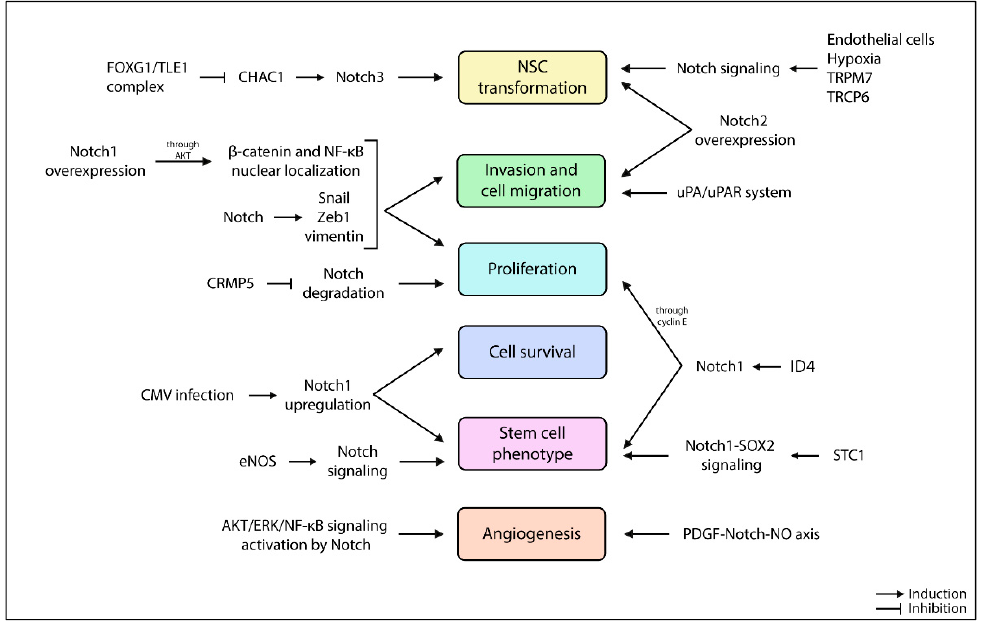
Figure 4. Other Notch-related tumorigenic aspects in the pathogenesis of GBM.